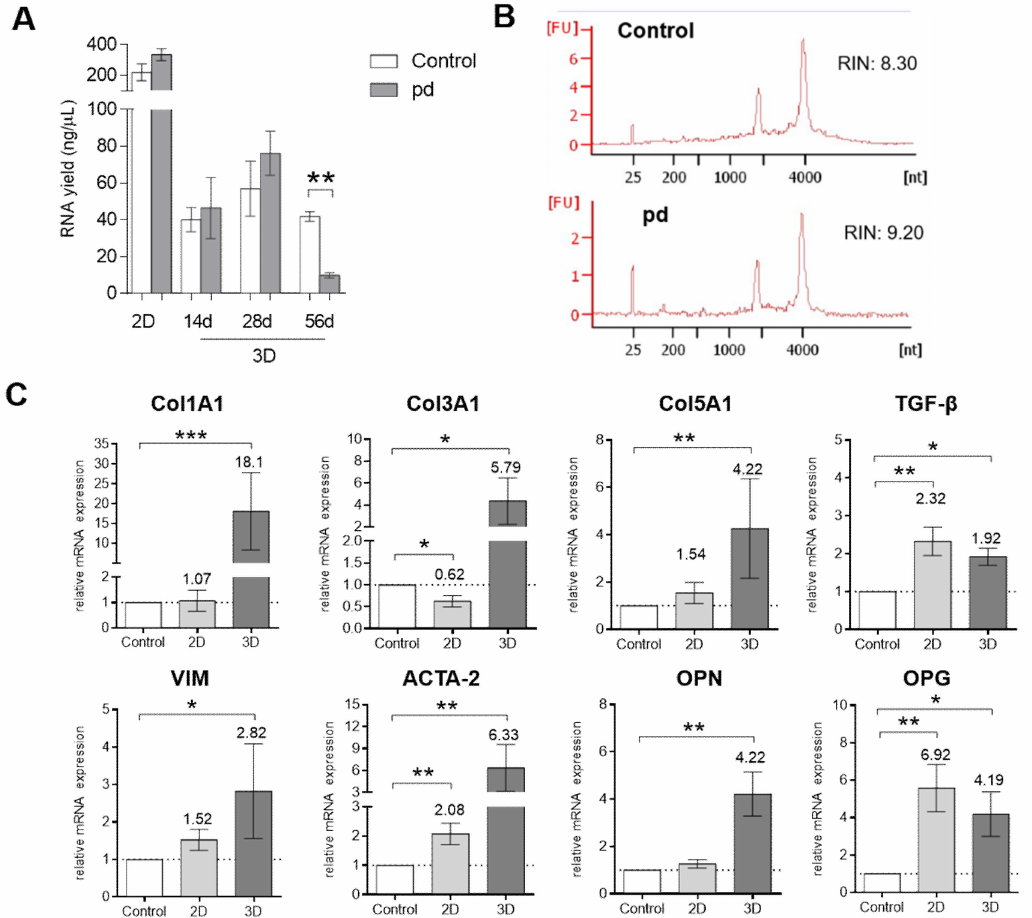
Figure 5. Gene expression analysis. ( A ) Comparative RNA yields of 2D VIC cultures (7 d) and AV leaflets after 14, 28, and 56 d cultivation under pro-degenerative (pd) conditions ( β -GP + CaCl 2 , dark column) compared to control conditions (white column). ( B ) Representative RNA integrity numbers (RINs) of AV leaflets after 28 d cultivation. ( C ) Analysis of gene expression of 2D VIC cultures (gray column, 7 d) and AV leaflets (dark column, 28 d) under pd conditions for alpha-1 type I collagen (Col1A1), alpha-1 type III collagen (Col3A1), alpha-1 type V collagen (Col5A1), transforming growth factor beta 1 (TGF- β 1), vimentin (VIM), alpha smooth muscle actin (ACTA2), osteopontin (OPN), and osteoprotergerin (OPG) compared to control conditions (white column). Data ( n = 6–8) are mean ± SEM. p -values are calculated by using Kruskal–Wallis test with Dunn’s multiple comparison post hoc test. *: p < 0.05; **: p < 0.01; ***: p < 0.001. FU, fluorescence